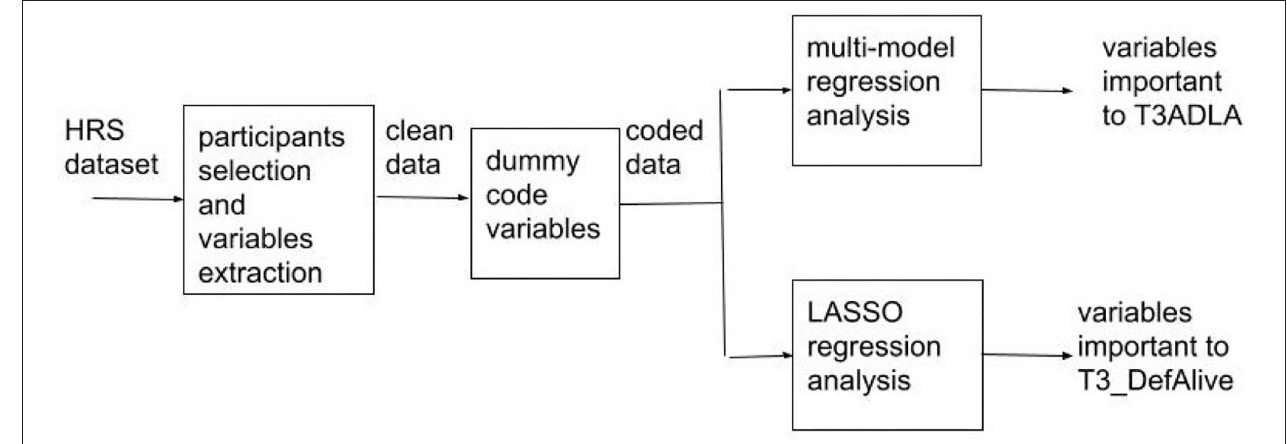
FIGURE 1 | Data analysis process. T3ADLA refers to a patient’s activities of daily living 4 years post-stroke, whereas T3_DefAlive is the variable definition of whether the patient is alive 4 years post-stroke.